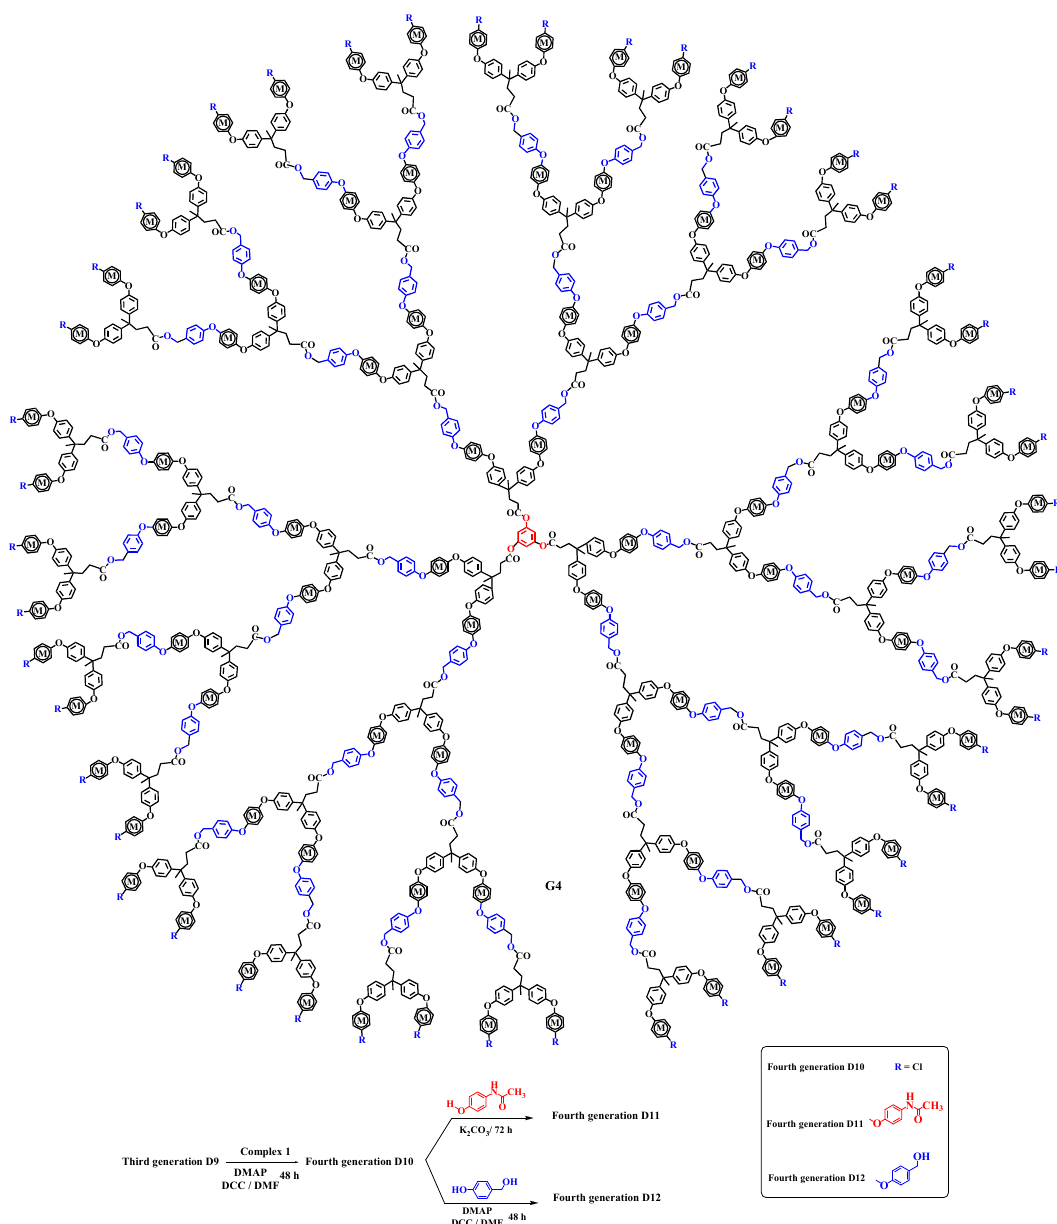
Scheme 4. Schematic representation of the synthesis of fourth-generation dendrimers ( D10–D12 ). 1 H and 13 C NMR and infrared (IR) spectroscopy as well as elemental analysis were used to characterize and identify the new dendrimers. For instance, second-generation D4 showed a downfield peak at 6.82 ppm, which referred to 24 protons in the twelve complexed outer aryl groups attached to the chloro end groups, and another upfield peak at 6.43 ppm, which represented 24 protons in the 12 complexed outer aryl groups attached to the etheric oxygen groups plus the 24 protons of the six iron-complexes in the first layer of the dendrimer. Additionally, a peak appeared at 5.28 ppm, which corresponded to the protons in the Cp attached to the chloro- end groups and another peak at 5.22 ppm, which corresponding to the 6 inner cyclopentadiene complexes. The second-generation D5 showed one upfield peak appearing at 6.25 ppm; the upfield peak was indicative of the protons close to the peripheral attached to the etheric oxygen groups. The equivalent protons of the iron-complexed